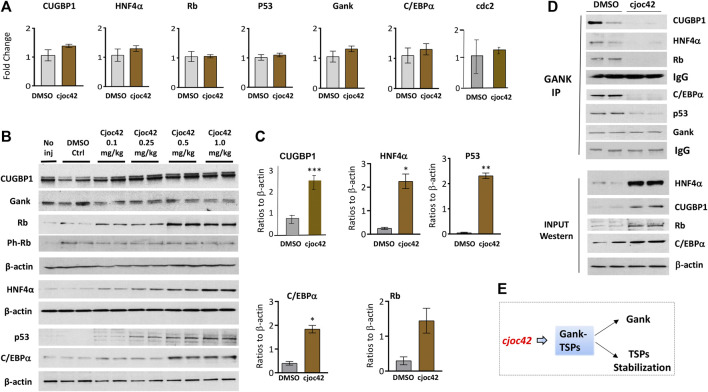
Treatments of WT mice with Cjoc42 inhibit interactions of Gank with TSPs and increase levels of the TSPs. (A) QRT-PCR analysis shows no difference in the mRNA levels of TSPs CUGBP1, HNF4α, Rb, p53, C/EBPα, Gank, and cell cycle marker cdc2 between DMSO and Cjoc42 treated mice. (B) Western blot analysis of TSPs and Gank in mice with no injection, DMSO, or varying doses of Cjoc42 (0.1, 0.25, 0.5, and 1 mg/kg). (C) Quantitation of western blots for p53 (p < 0.0024), C/EBPα (p < 0.014), Rb (p > 0.05), CUGBP1 (p < 0.004) and HNF4α (p < 0.01) comparing DMSO to Cjoc42 1 mg/kg dose. (D) Co-IP studies with DMSO treated and Cjoc42 (1 mg/kg) treated mice. The upper image shows the results of Co-IP. The bottom image shows input (loading of proteins). IgG shows signals of heavy chains of immunoglobulins G added to the IP reactions. (E) The diagram summarizes the results of Cjoc42 treatments on the stability of TSPs in livers.